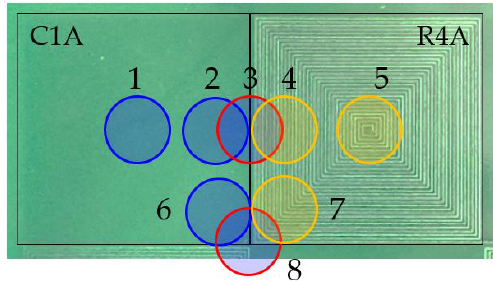
Figure 9. MO positions in a detection coil array. Table 4. Voltage and phase variation according to positions.